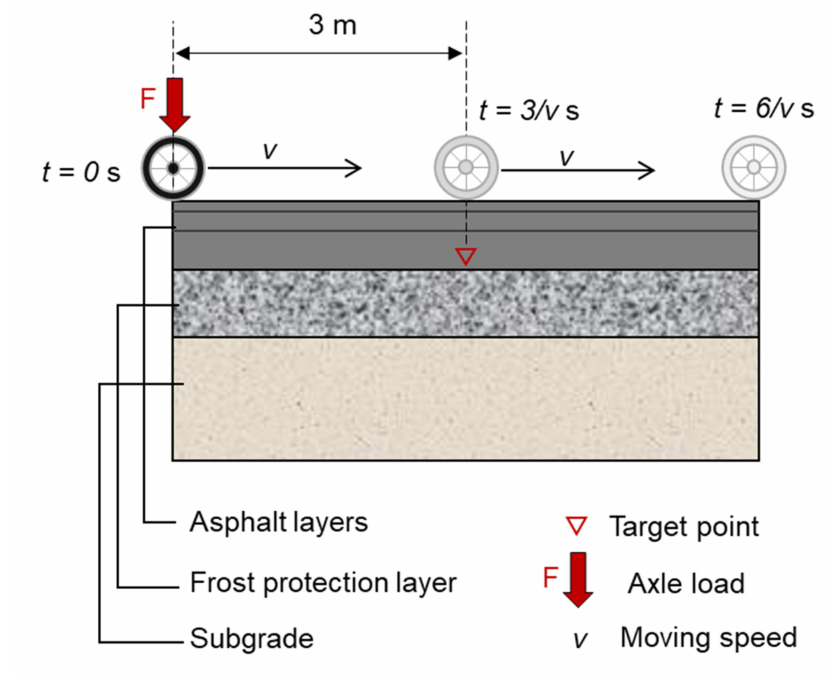
Figure 1. Schematic diagram of the pavement model.